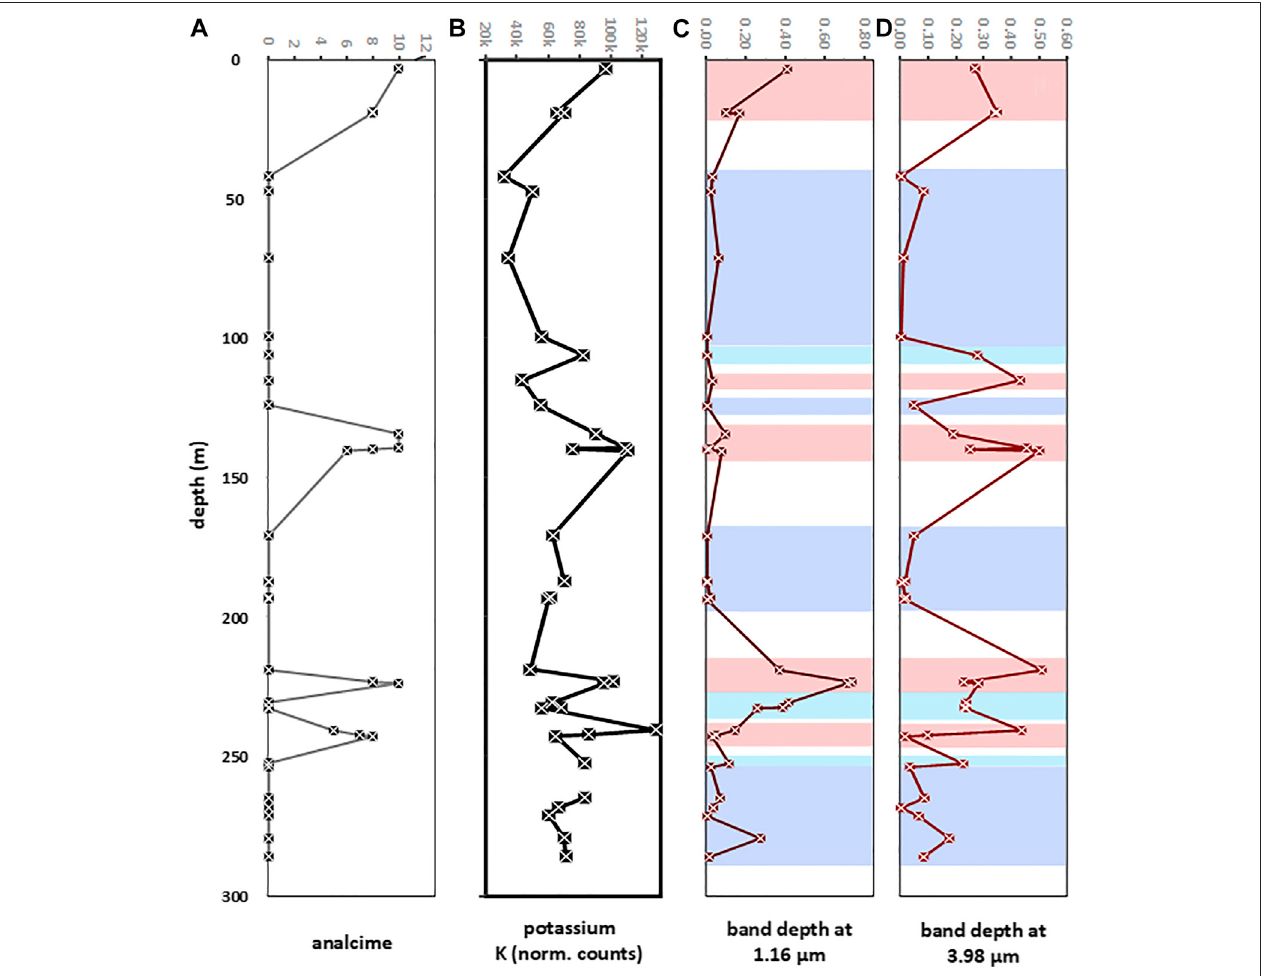
FIGURE 7 | Comparison of absorption band depths at 1.16 μ m (characteristic for analcime) and at 3.98 μ m (calcite) with K values (scanning XRF, normalized counts per second) and analcimeintensities(XRD, normalized). (A) Analcime, (B) potassium, (C) band depthat1.16 µm,and (D) band depthat3.98 µm.Colorshading indicates inferred hydroclimate:red:dry-climate sediment; lightblue: wet-to-dry-transition-climate sediment; blue: wet-climate sediment,derived fromspectralanalysis.